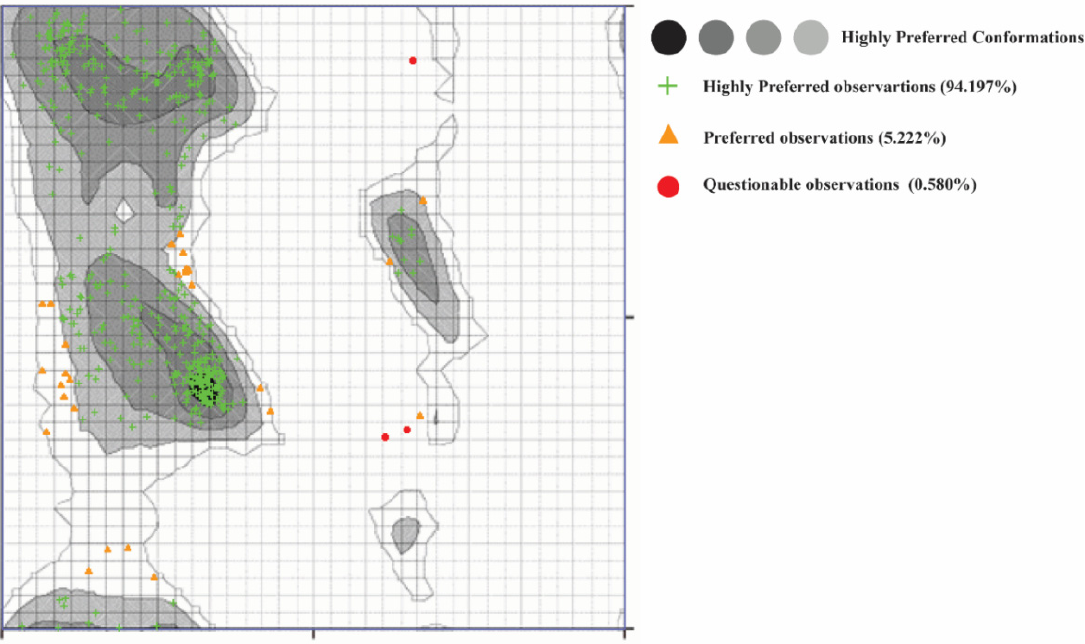
Figure 8. Ramachandran plot of α -glucosidase represents the highly favorable regions in green, allowed region in orange, and disallowed residues in red.